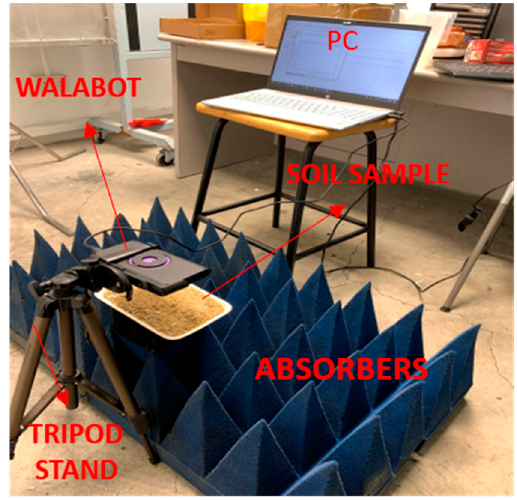
Figure 2. Experimental Setup.